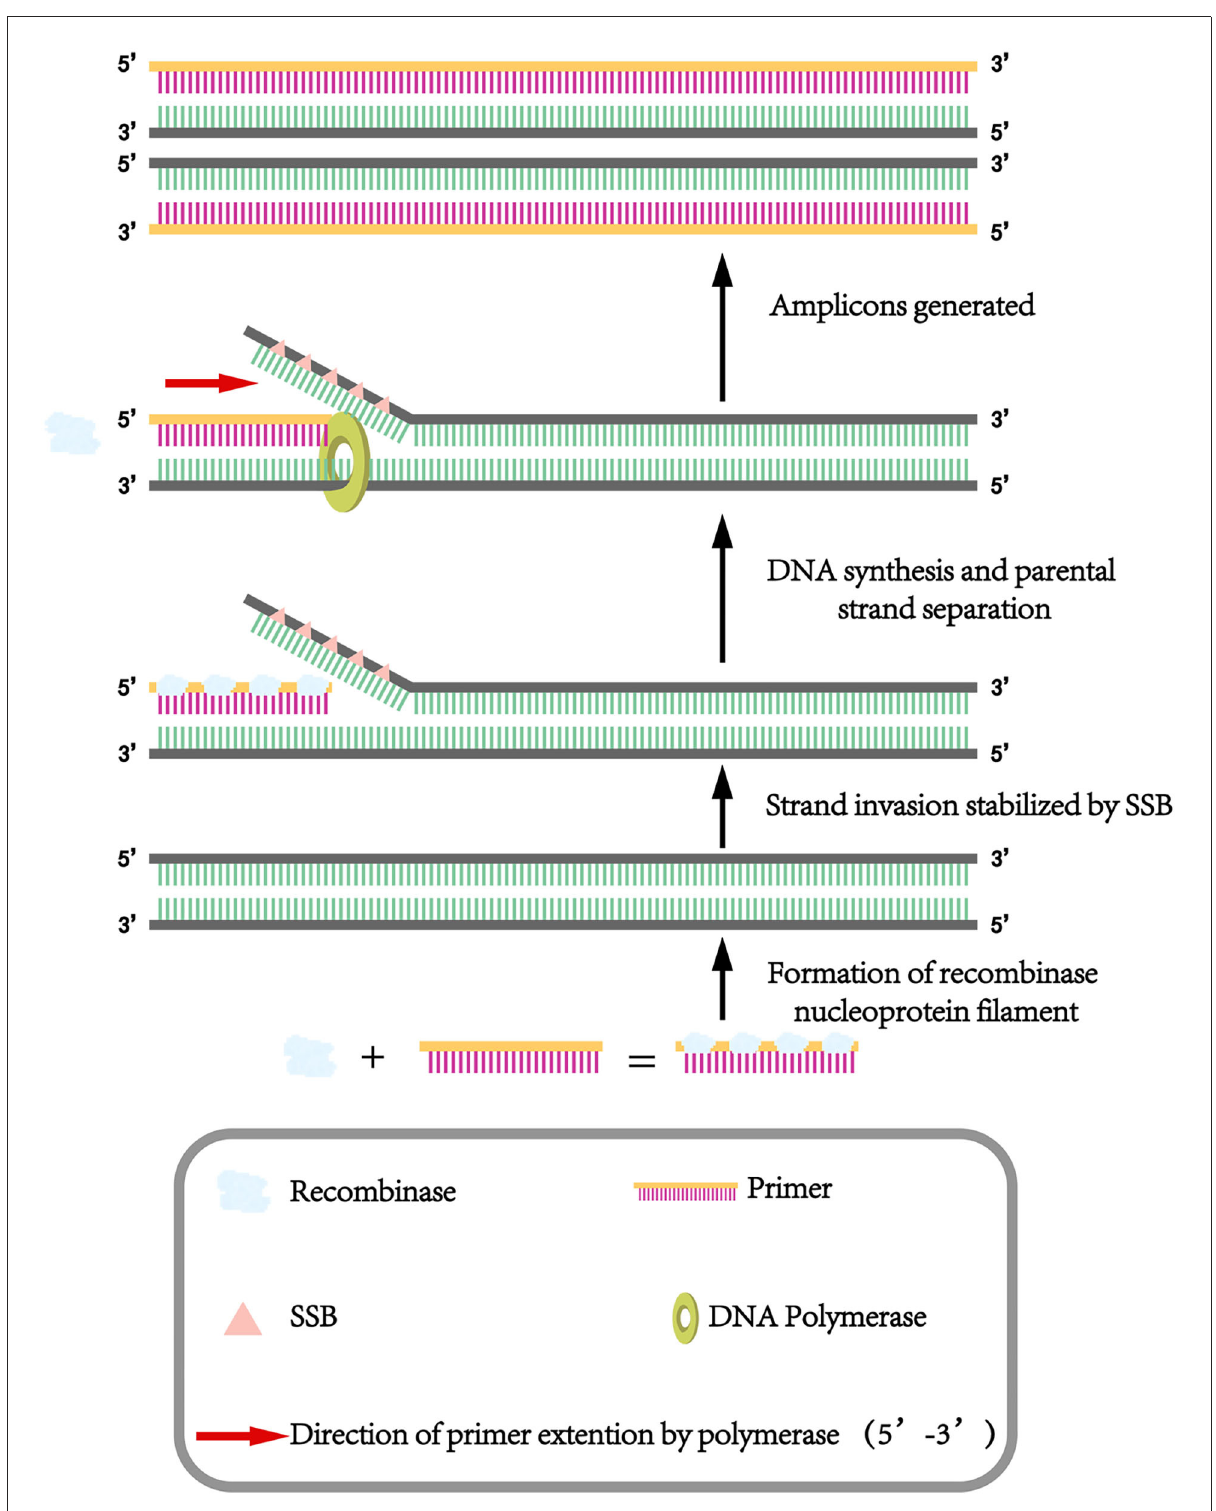
FIGURE1 Schematic diagram of the